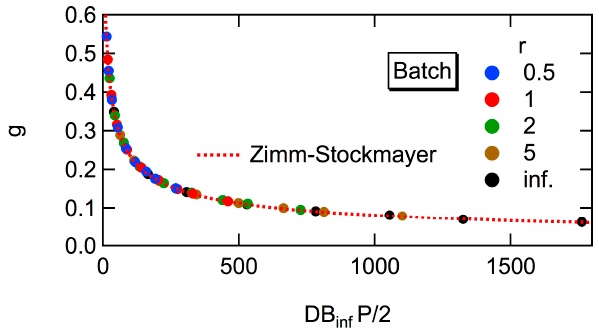
Figure 14. Comparison with the Zimm-Stockmayer equation.